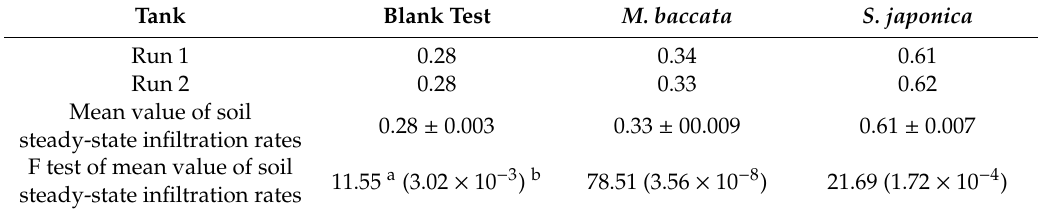
Table 1. Soil steady-state infiltration rates (m / d) at the bottom outlets of three test tanks.